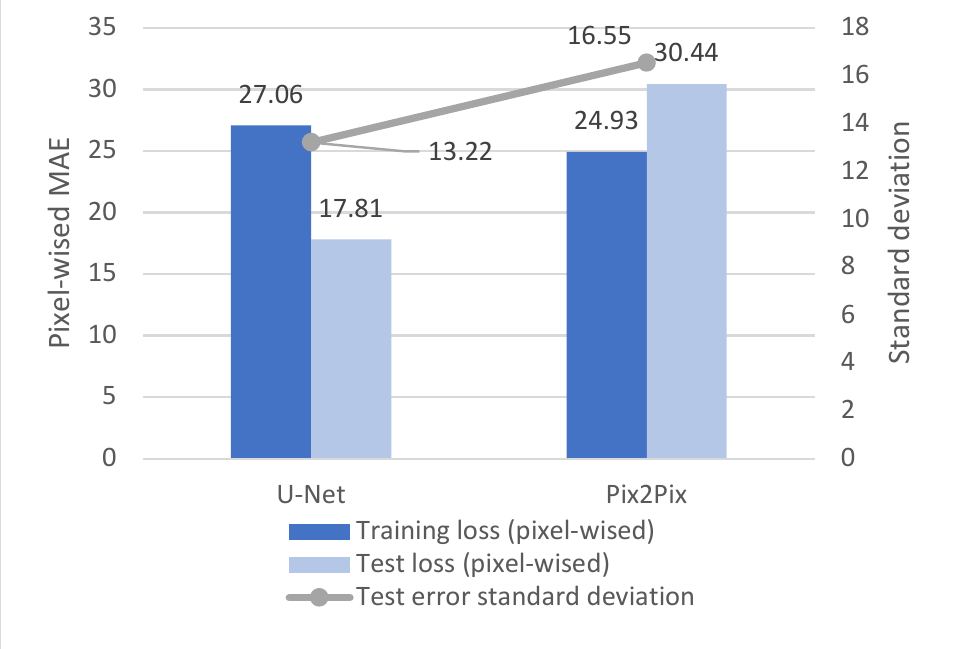
Figure 7. Comparison of the performances of Pix2Pix and U-Net. The test results of the presented U-Net based framework and Pix2Pix structure are shown in Figure 8. To visualize the radiation, the grey value was mapped using a look-up table (LUT) of ‘thermal’ in Fiji [25]. High radiation on layer 300, due to the critical overhang structure on the top of the hole, was predicted by both algorithms.